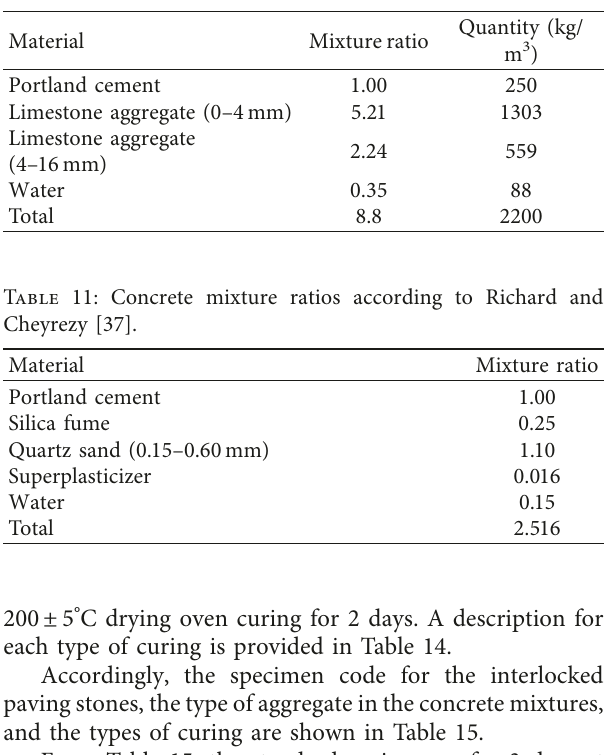
Figure 4: Gradation curve of aggregates for RWC and RCC. Table 10: The mixture ratio and amounts of RWC and RCC interlocked paving stones.